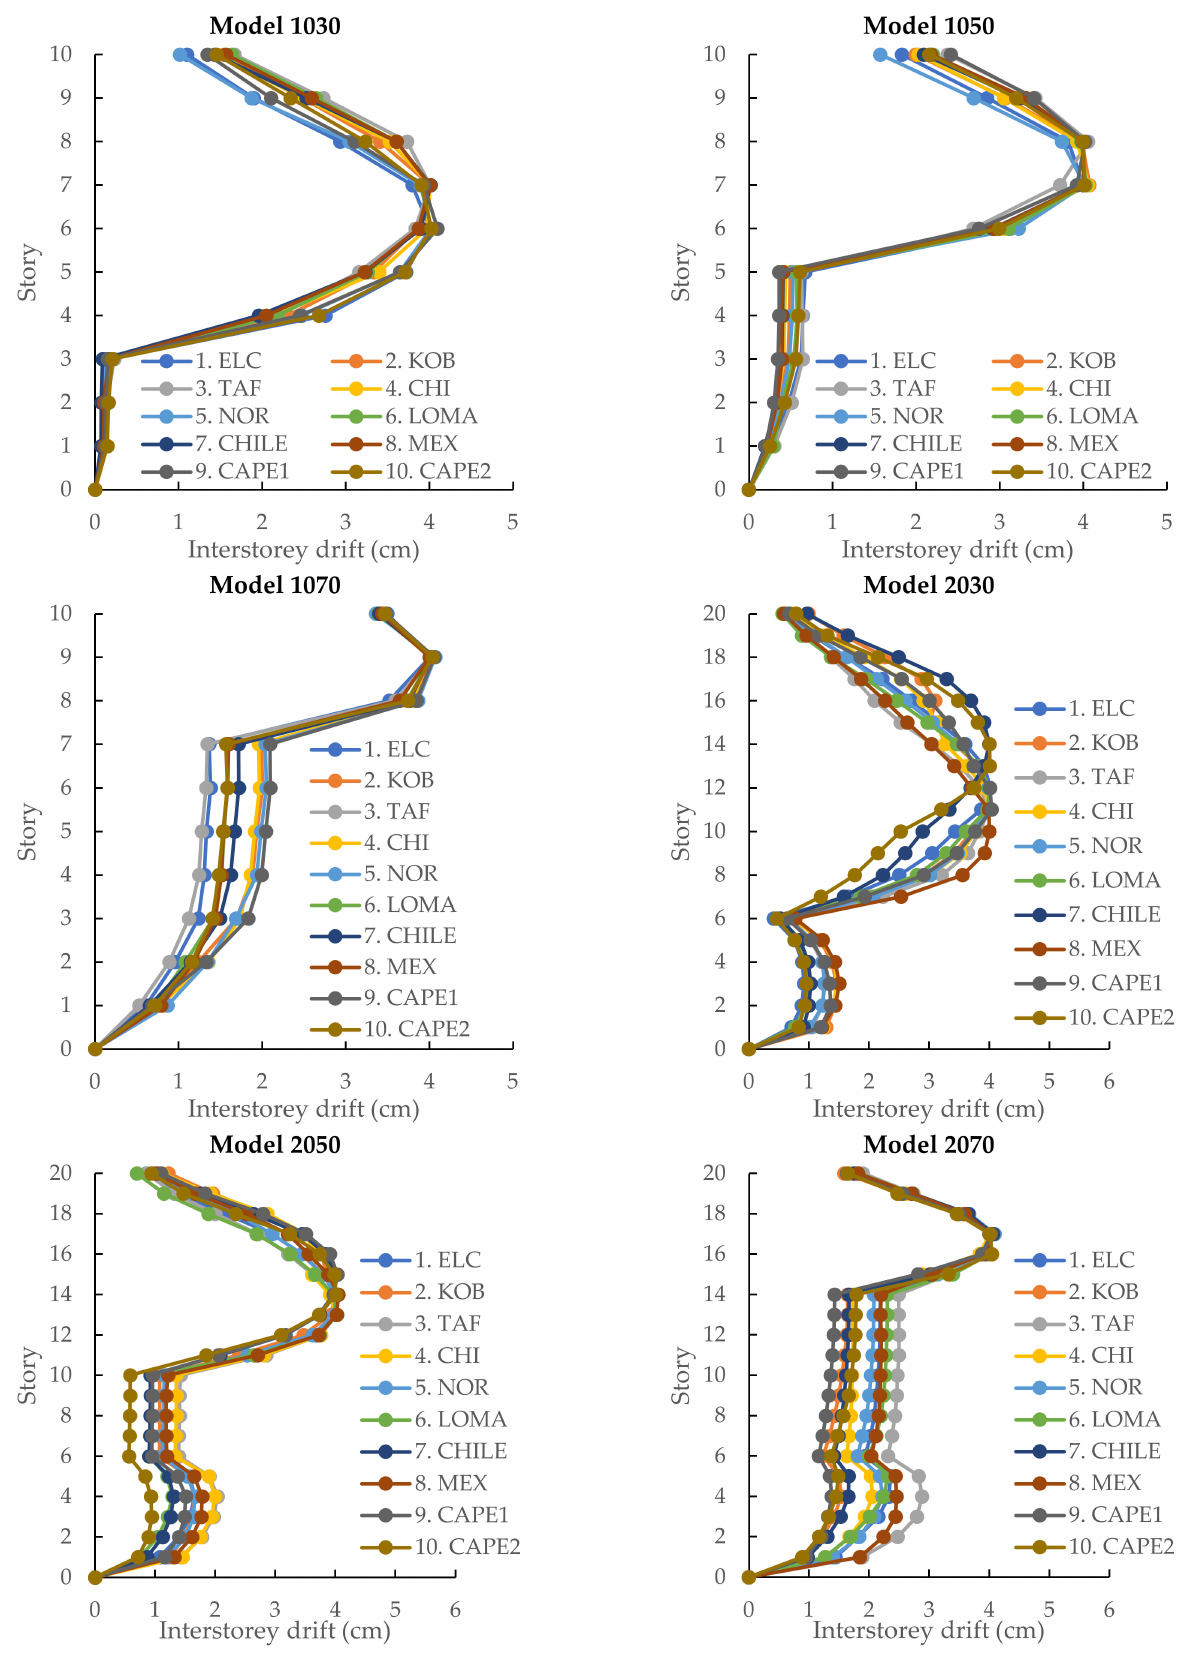
Figure 16. Inter-story drift of six specimens under ten selected input